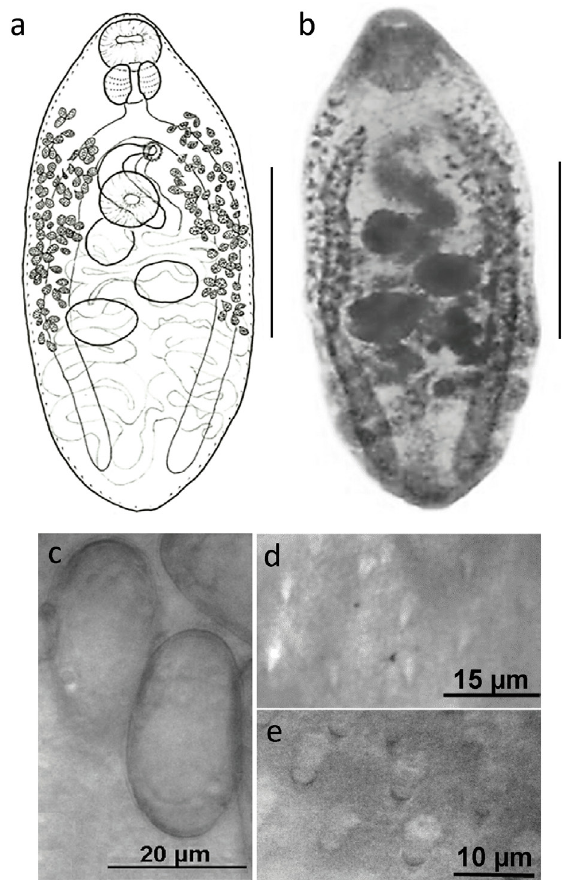
Figure 4. Choledocystus elegans ( a , b ) body in ventral view, ( c ) detail of eggs in the uterus, ( d ) tegumental spination of anterior ventral body region, ( e ) tegumental spination of posterior ventral body region. Scale bars: a, b = 500